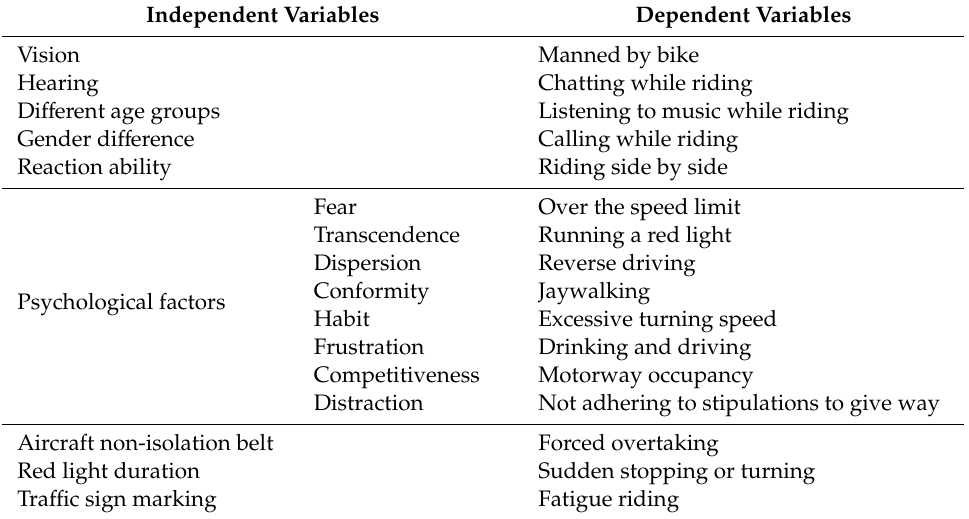
Table 2. Independent and dependent variables used in previous